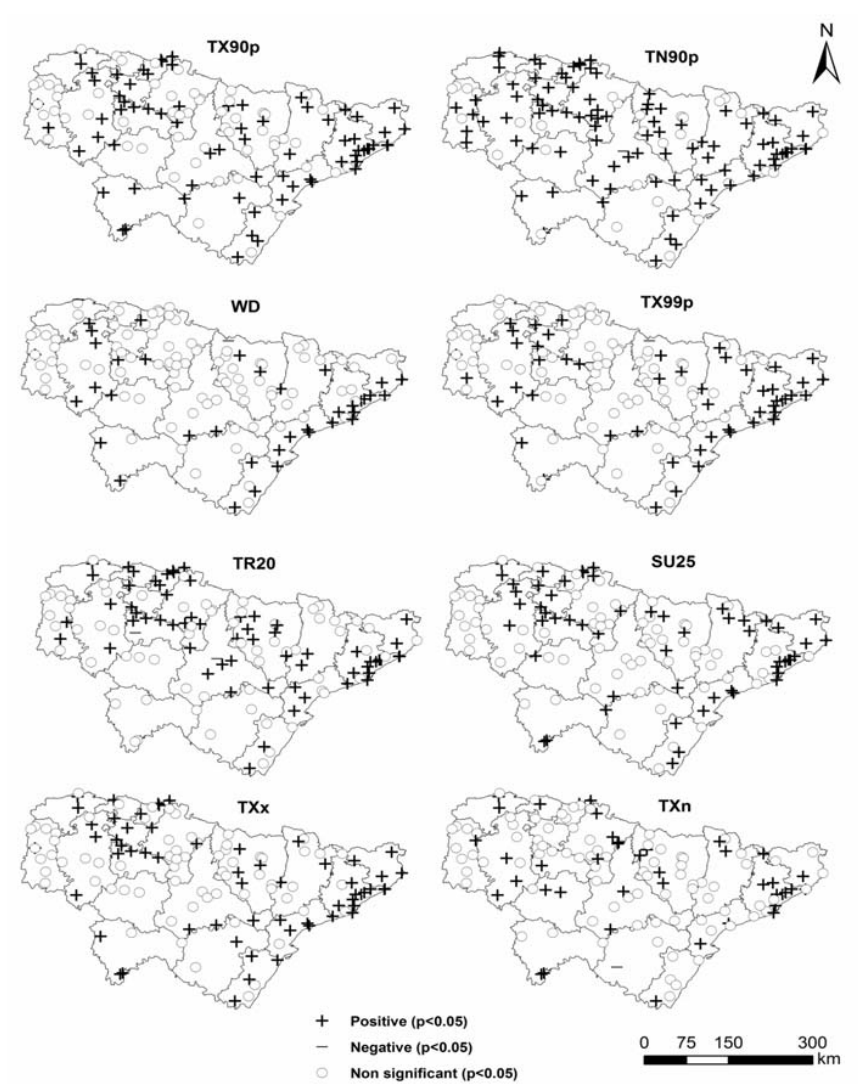
Figure 5. Spatial distribution of the trends in hot extreme indices over the